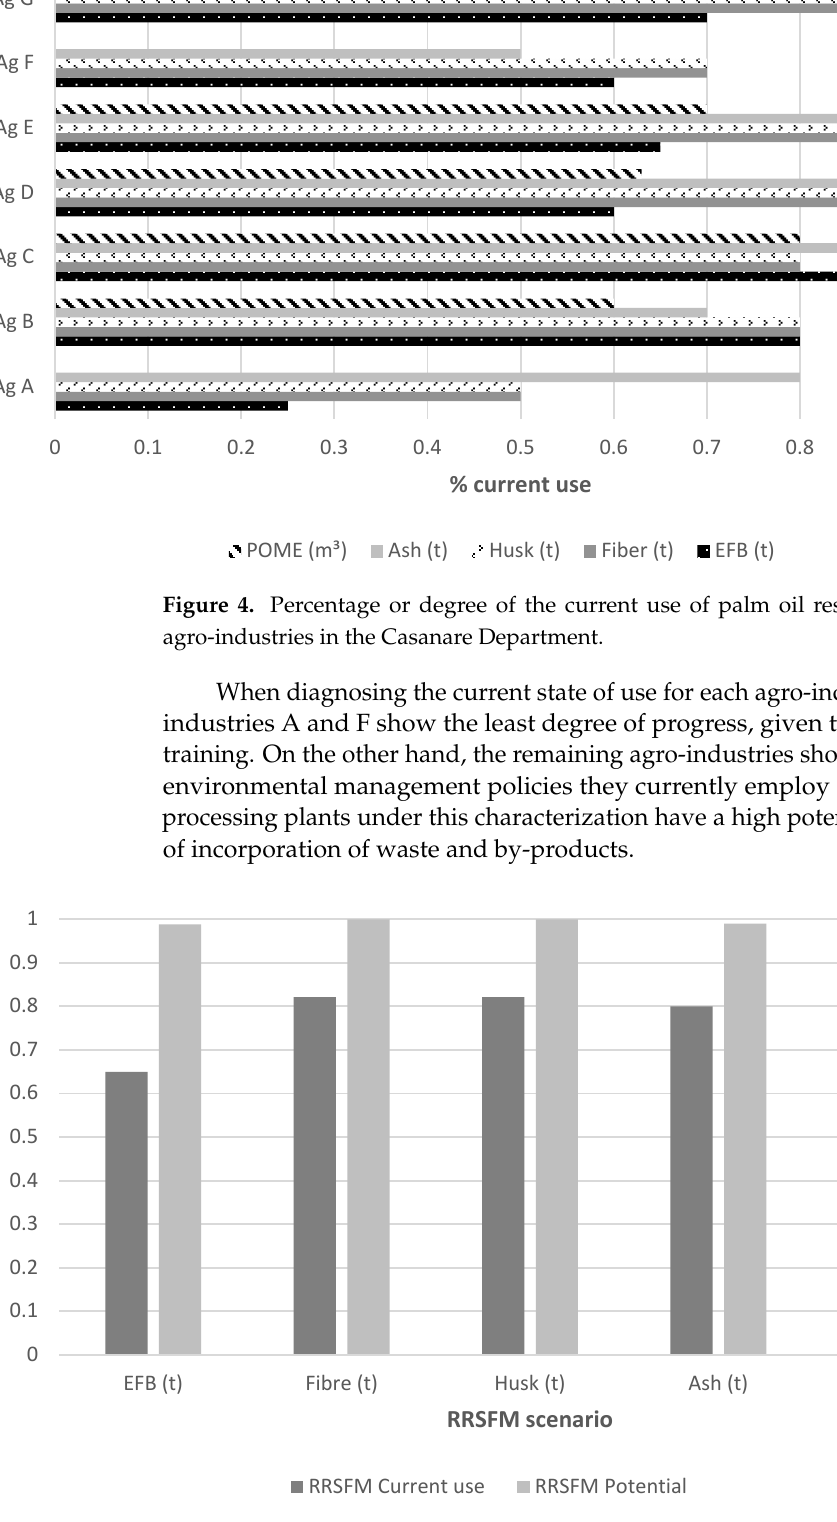
Figure 5. Comparison of the circular economy model under the current and potential scenarios of the reincorporation of palm oil waste and by-products in the Casanare Department.